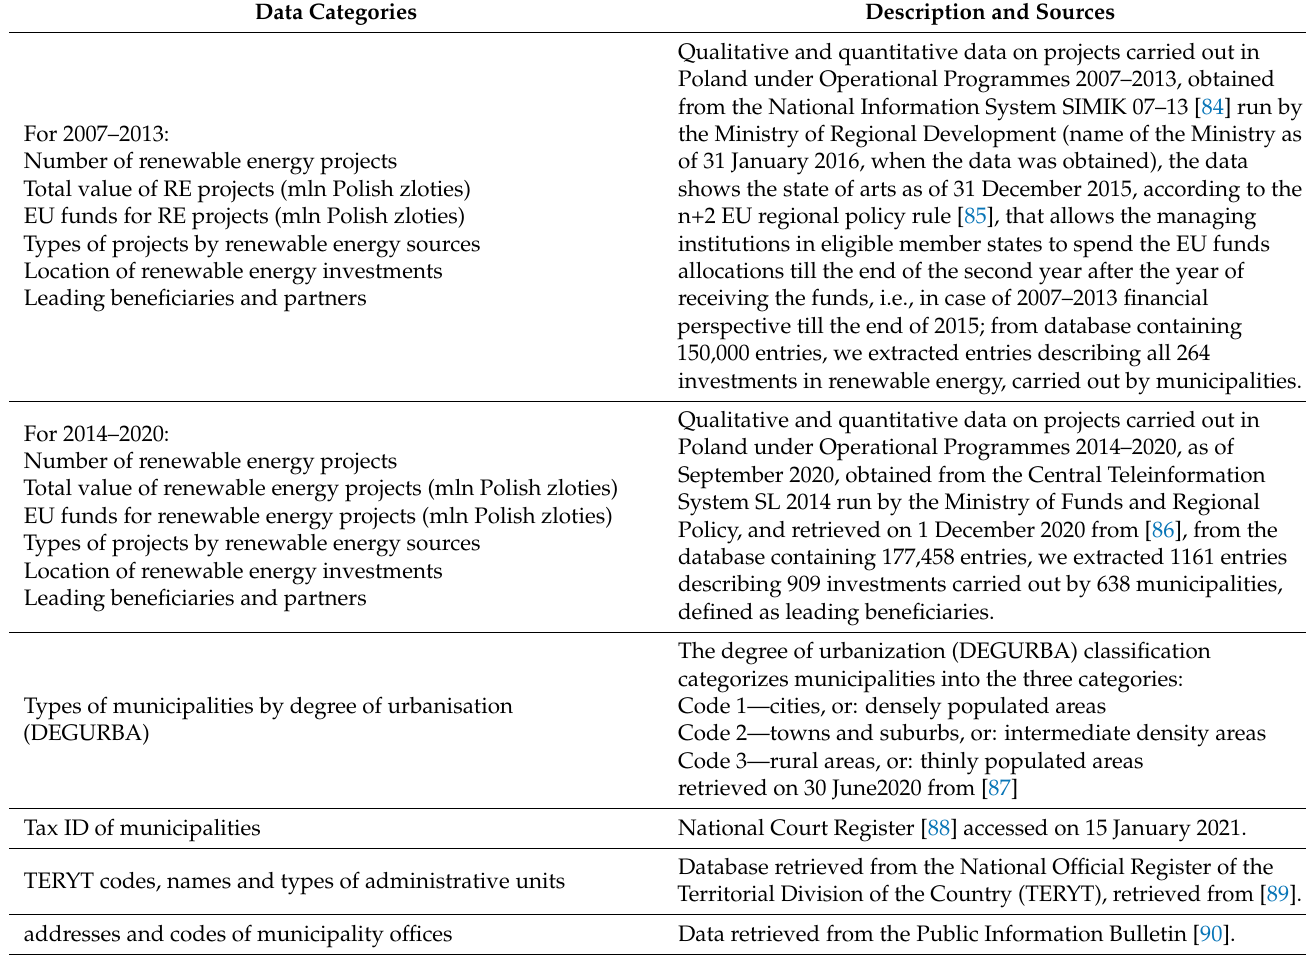
Table 1. Data categories and sources.